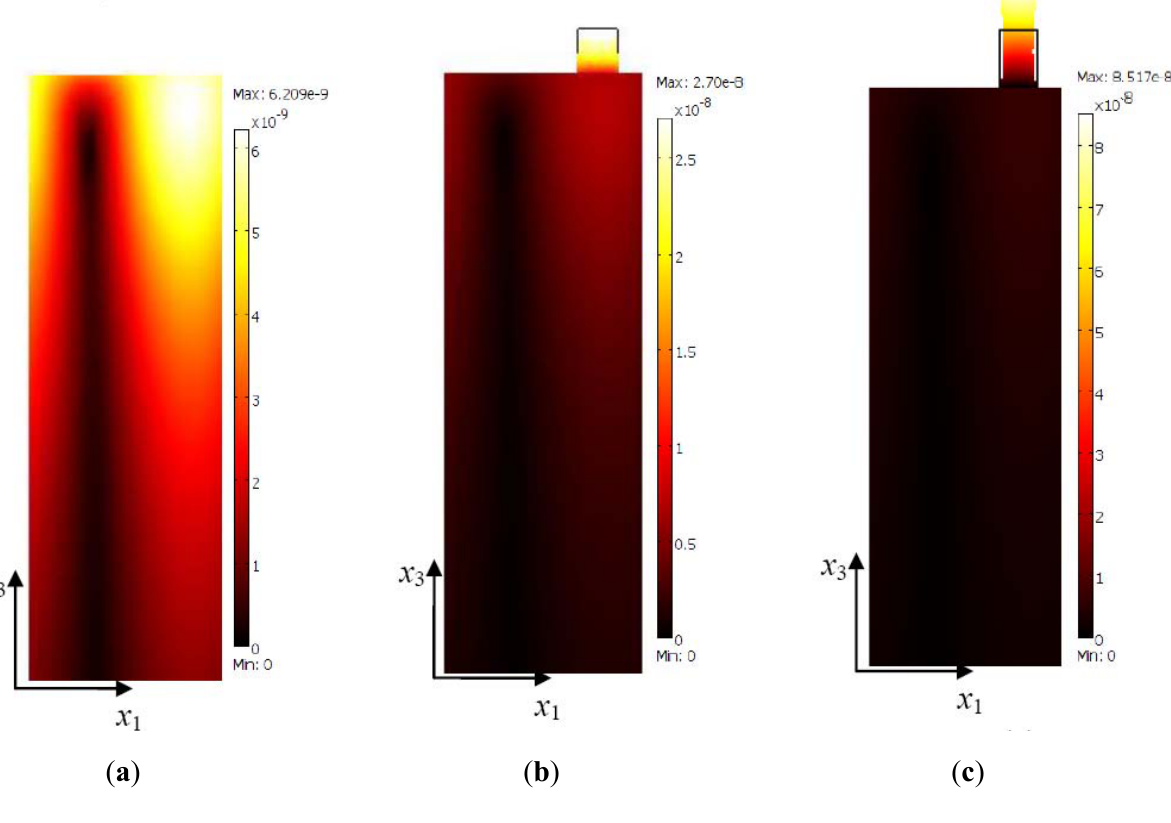
SU-8 pillars of height ( a ) h = 0 µm (no pillar), ( b ) h = 10 µm, ( c ) h = 12 µm, ( d ) h = 23